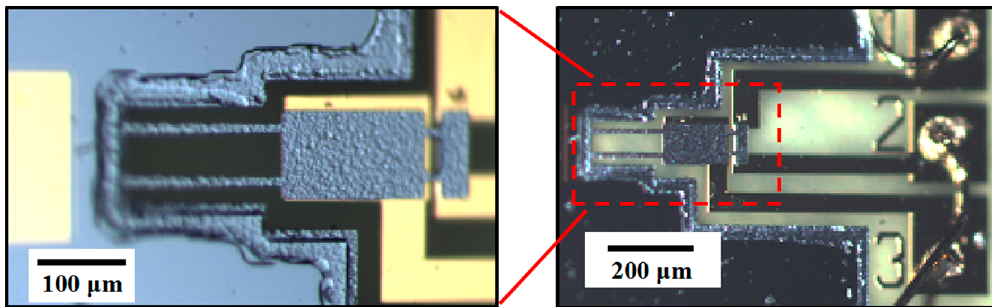
Figure 10. Inertial micro ‐ switch.